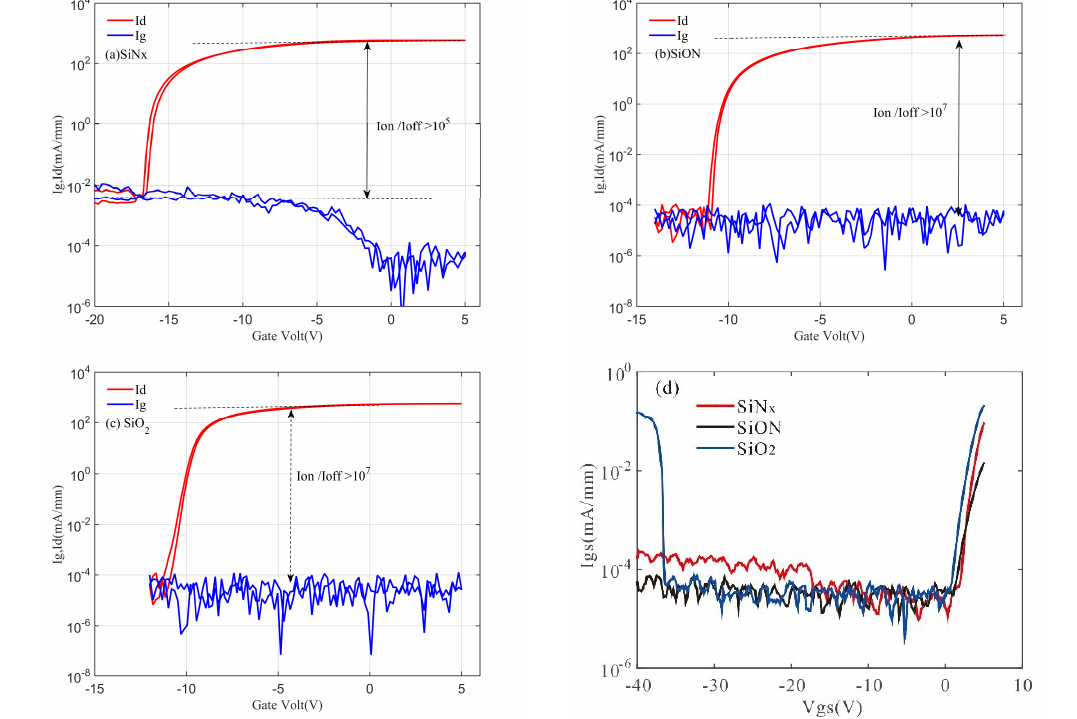
Figure 3. Transfer characteristic of ( a ) SiN x MIS-HEMT, ( b ) SiON MIS-HEMT, and ( c ) SiO 2 MIS-HEMT, and ( d ) gate leakage current curve measured at two terminals for the three samples.